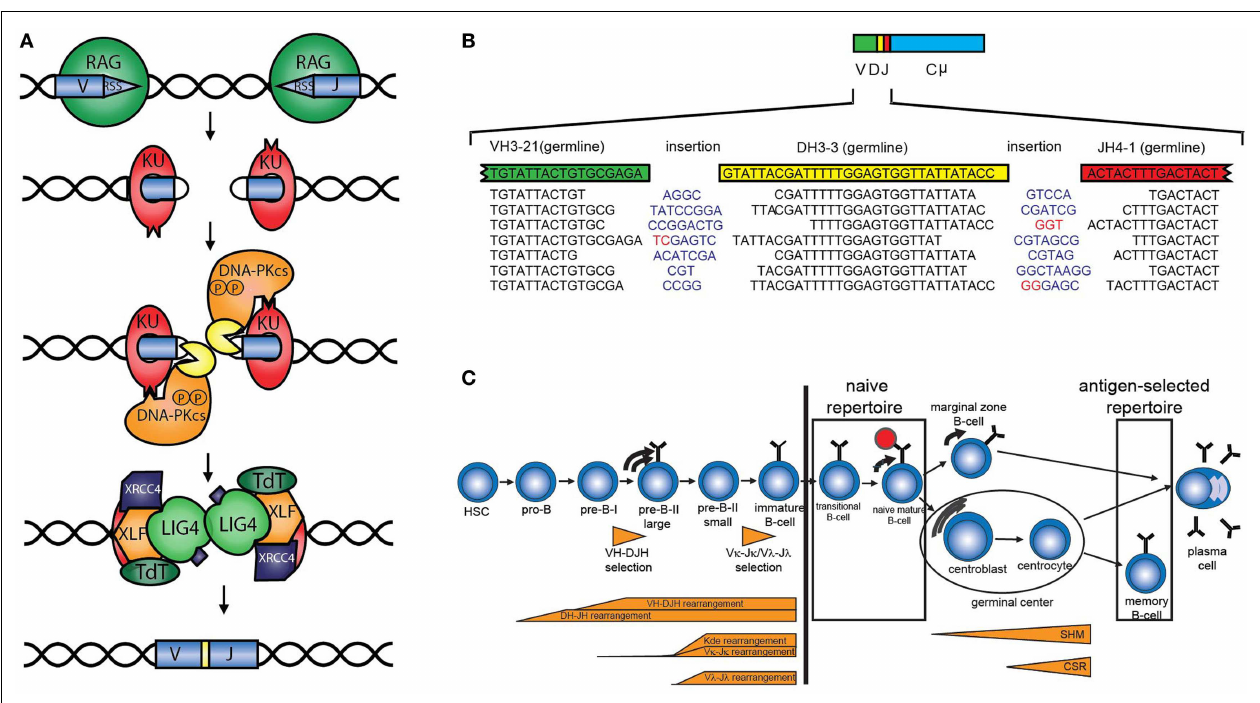
showing junctional diversity by nucleotides that are removed, non-templated (N) nucleotides (blue) that are added, or presence of palindromic (P) nucleotides (red). (C) The B-cell repertoire in peripheral blood can be divided into the naive repertoire and the antigen-selected